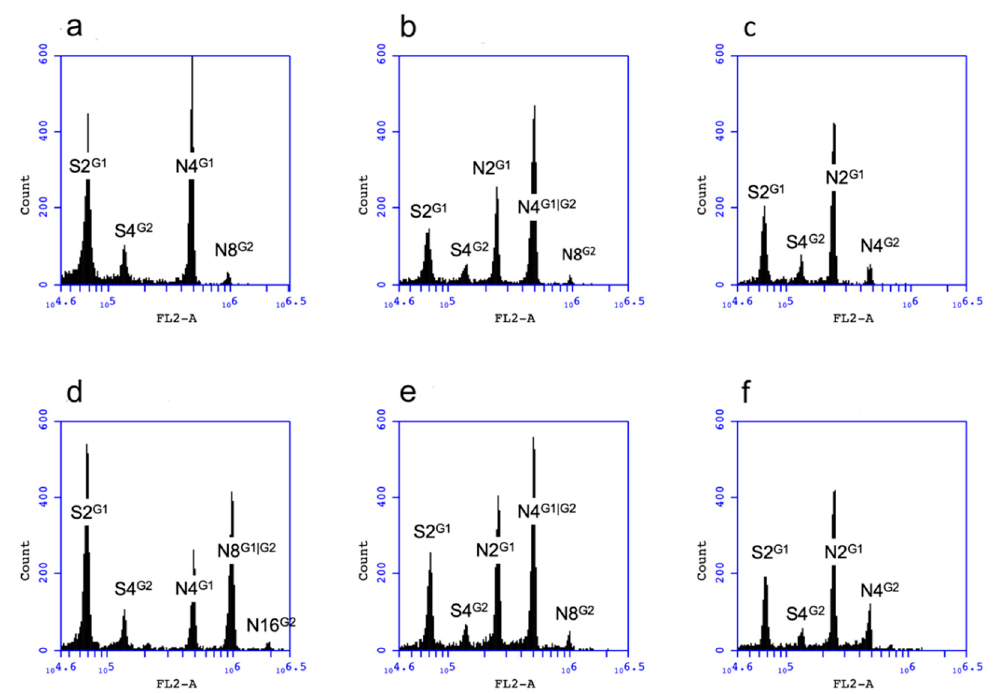
Figure 1. Representative flow cytometry analysis. ( a ) A bulked sample of five non-transgenic tobacco plants; ( b ) a bulked sample of T1 progeny of a haploid-producing 4 x ddBR1 line (ddBR1_240.2) with 2